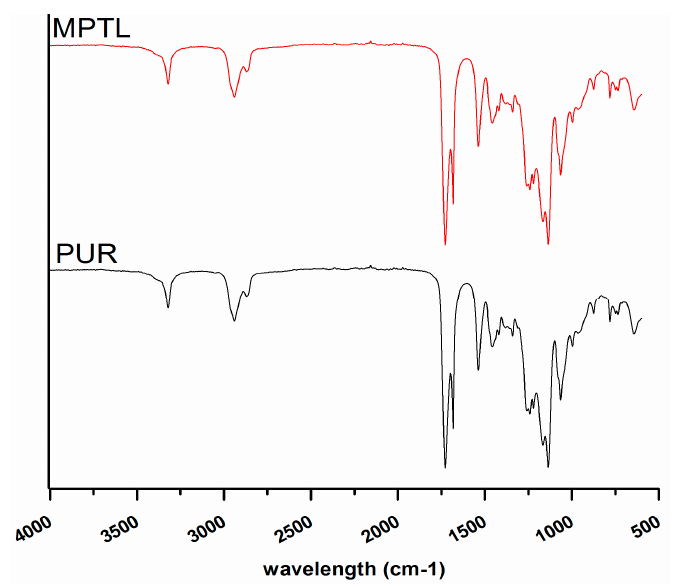
Figure 2. FTIR spectra of PUR and MPTL scaffolds. Table 1. Spectral data* and band assignments of FTIR analysis presented in Figure 2. Native PUR and MPTL Scaffold